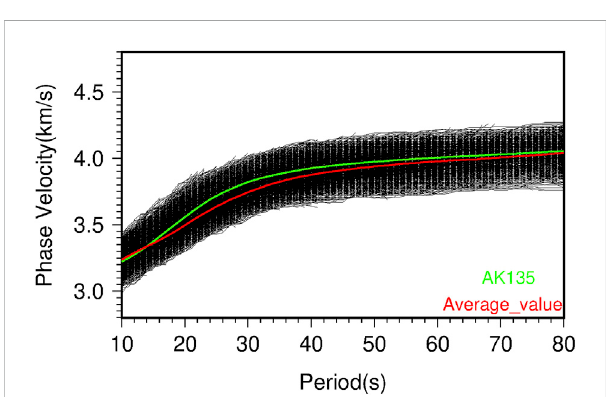
FIGURE 3 Surface-wave phase velocity dispersion curves. The black lines are15,157high-qualitydispersioncurves.Theredandgreensolidlines represent the average phase velocity and the AK135 model